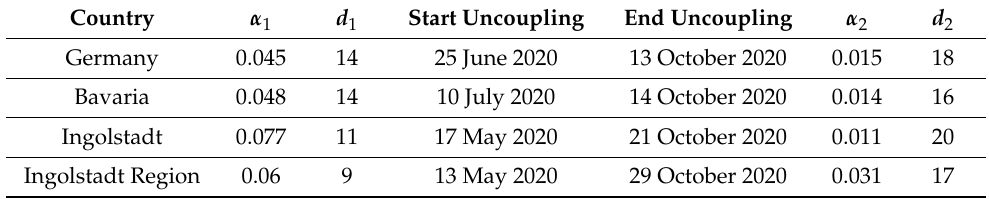
Table 1. Estimated parameters of the 3-phase model for Germany, Bavaria, the city of Ingolstadt, and the Ingolstadt region. In all four cases, we see an increase of the shift parameter from the first to the second wave, and a decrease of the case-fatality rates. Comparing Ingolstadt and the neigh- boring region, it is striking that the case-fatality rates flip order, the Ingolstadt region having by far the highest case-fatality rate of all four considered entities in the fall of 2020. Country α